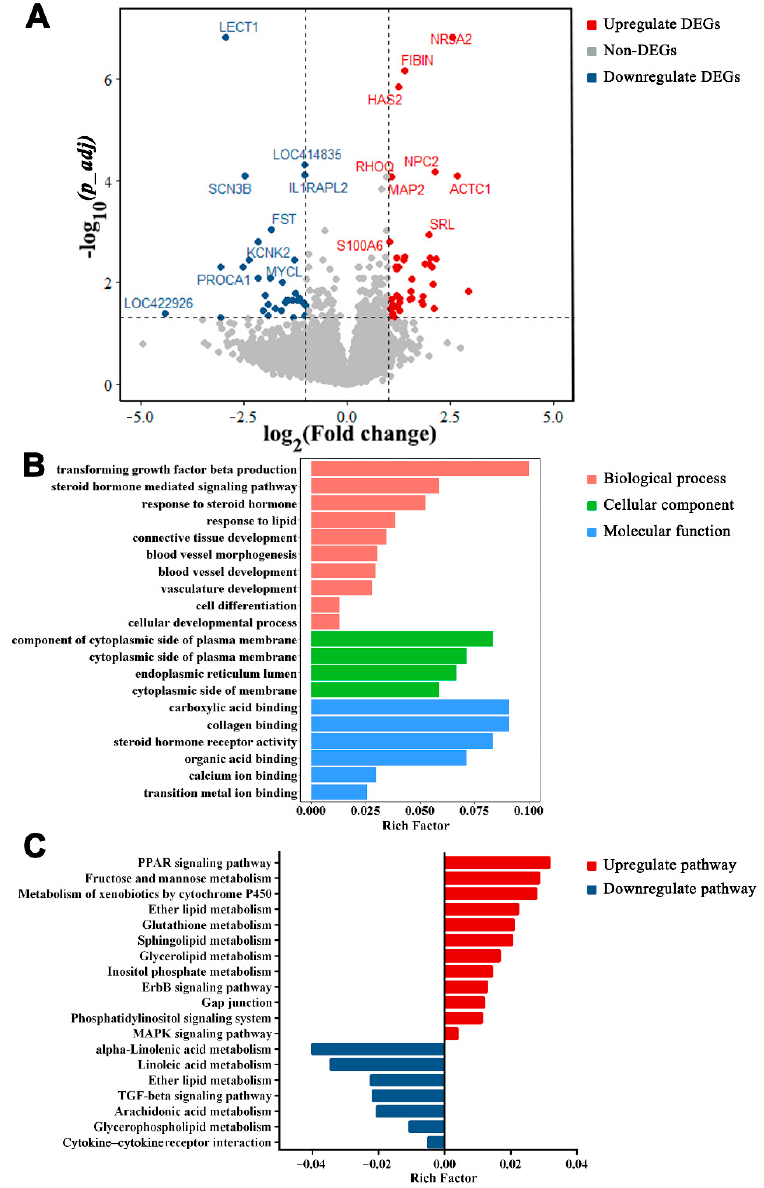
Figure 7. Differentially expressed genes (DEGs) in small yellow follicles (SYF) vs. large yellow follicles (LYF). ( A ) Volcano map of DEGs in SYF vs. LYF. DEGs with p_adj < 0.05 and log fold change ≥ 1 are 2 marked in red, and DEGs with p_adj < 0.05 and log fold change ≤ − 1 are marked in blue. ( B ) Gene 2 Ontology functional classification of DEGs in biological process, cellular component, and molecular function categories. ( C ) Kyoto Encyclopedia of Genes and Genomes pathways of